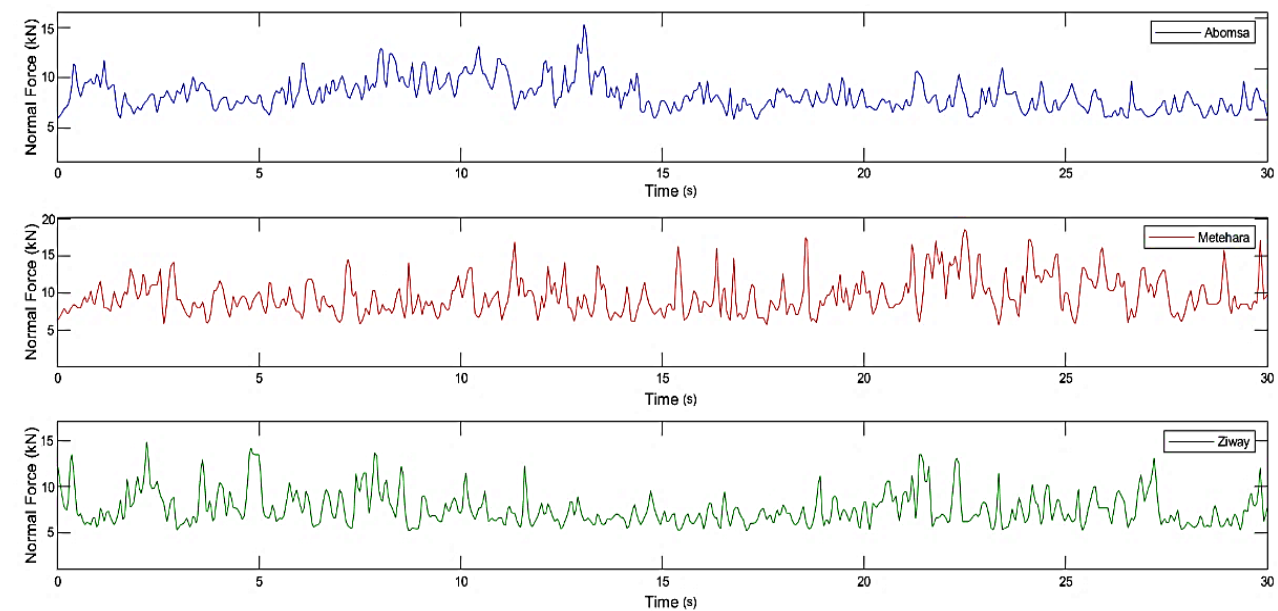
Figure 16. Normal force acting on wind turbine blade for three selected sites.